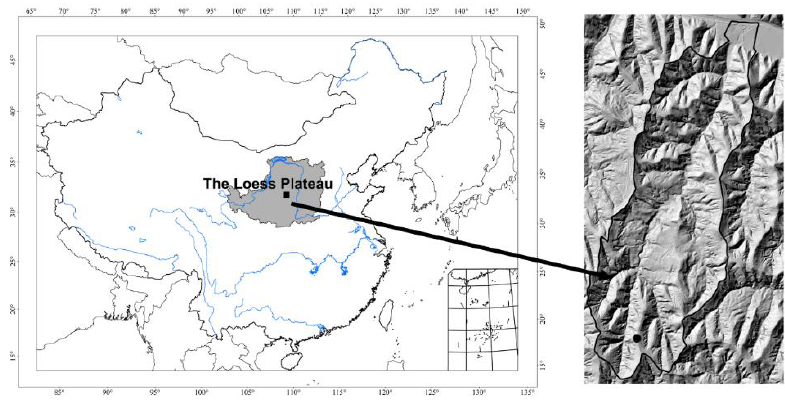
Figure 1. Location of the Loess Plateau and the study site.